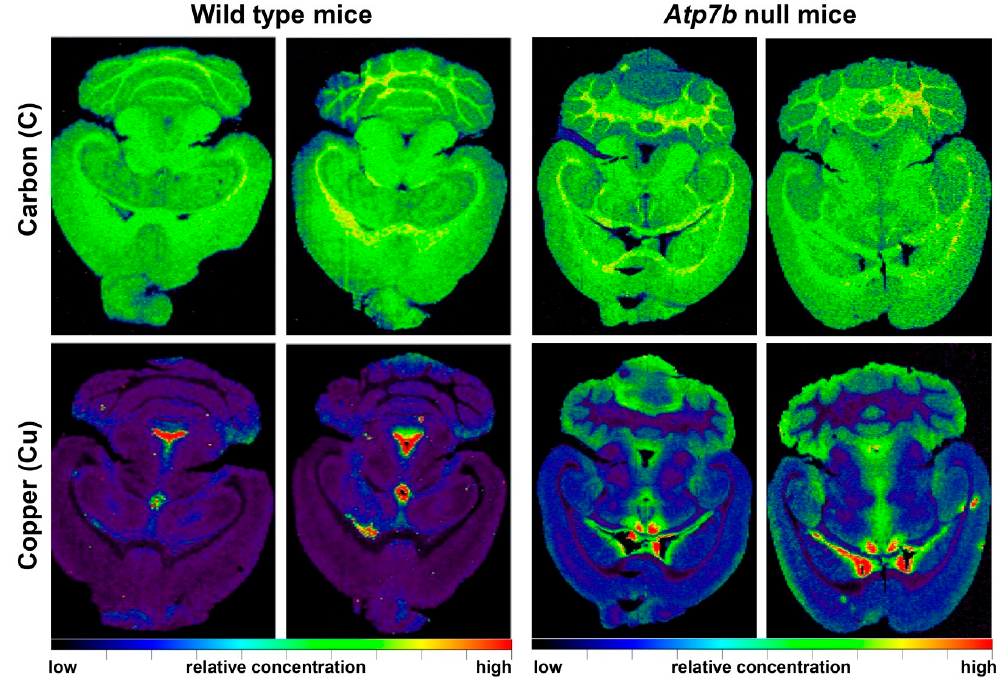
Figure 6. Comparative LA-ICP-MSI of Cu in brains of wild type and Atp7b null mice. Two representative brain sections, each taken from adult wild type (left) and Atp7b null mice (right) were imaged for carbon (C) and copper (Cu). Depicted are relative concentrations of Cu which were normalized to the content of C. The increase of cerebral Cu in Atp7b null mice predominantly affects specialized brain areas. Details about age-dependent accumulation of Cu in Atp7b null mice are given elsewhere [37,38].